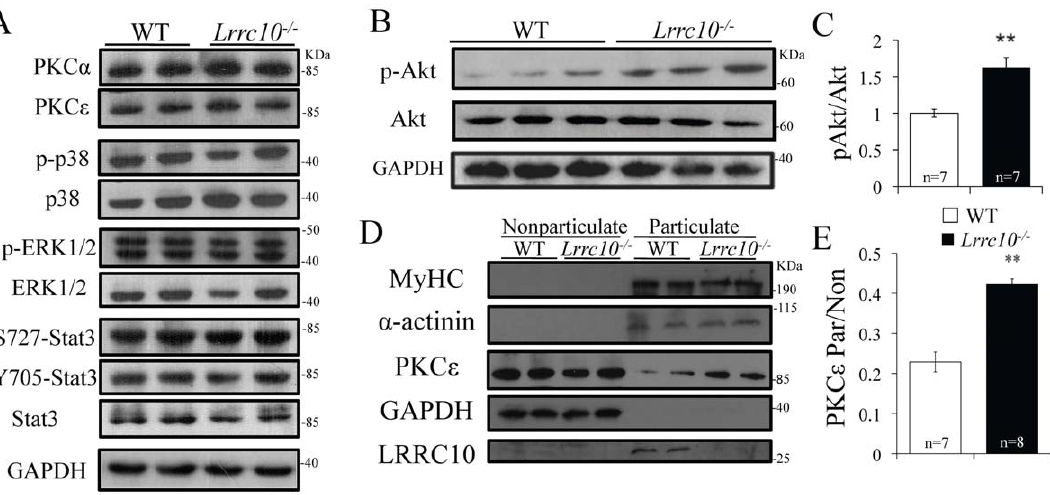
Figure 6. Signal transduction in Lrrc10 2 / 2 hearts. (A) Western blotting analysis for activation of Akt, p38, ERK, and STAT signaling pathways and PKC expression reveals no changes in phosphorylation of p38, ERK, or STAT or protein abundance of PKC a or PKC e . (B) Western blotting indicates hyperphosphorylation of Akt at Ser 473 in Lrrc10 2 / 2 hearts. (C) Quantitation of Western blotting confirms increased phosphorylation of Akt in Lrrc10 2 / 2 hearts (n=7). Phosphorylated Akt was normalized to total Akt expression and GAPDH was used as a loading control. (D) Representative Western blotting of particulate and nonparticulate fractions of adult heart extracts in control (WT) and Lrrc10 2 / 2 mice. (E) Quantification of PKC e expression in the particulate fraction relative to the nonparticulate fraction. Myosin heavy chain (MyHC) and a -actinin were used as a particulate/ myofilament loading control.